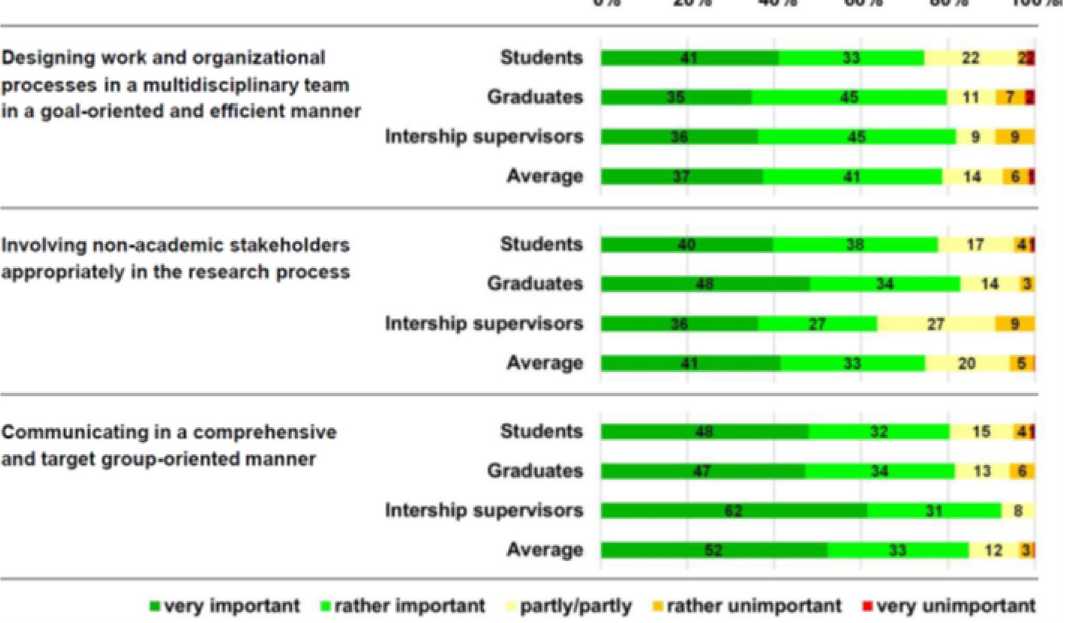
Fig. 3 Assessment regarding the importance of fostering social and communicative competencies from the perspective of students, gradu- ates, and internship supervisors, as well as the average of the three estimations in % (students are N = 102/103/102 from top to bottom; graduates N = 89/87/87; and internship supervisors N =